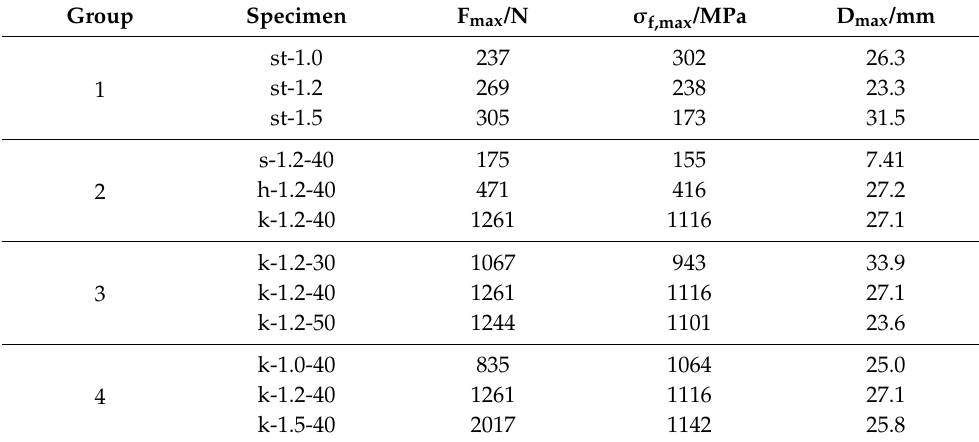
Table 4. The main pullout mechanical parameters of test specimens a .